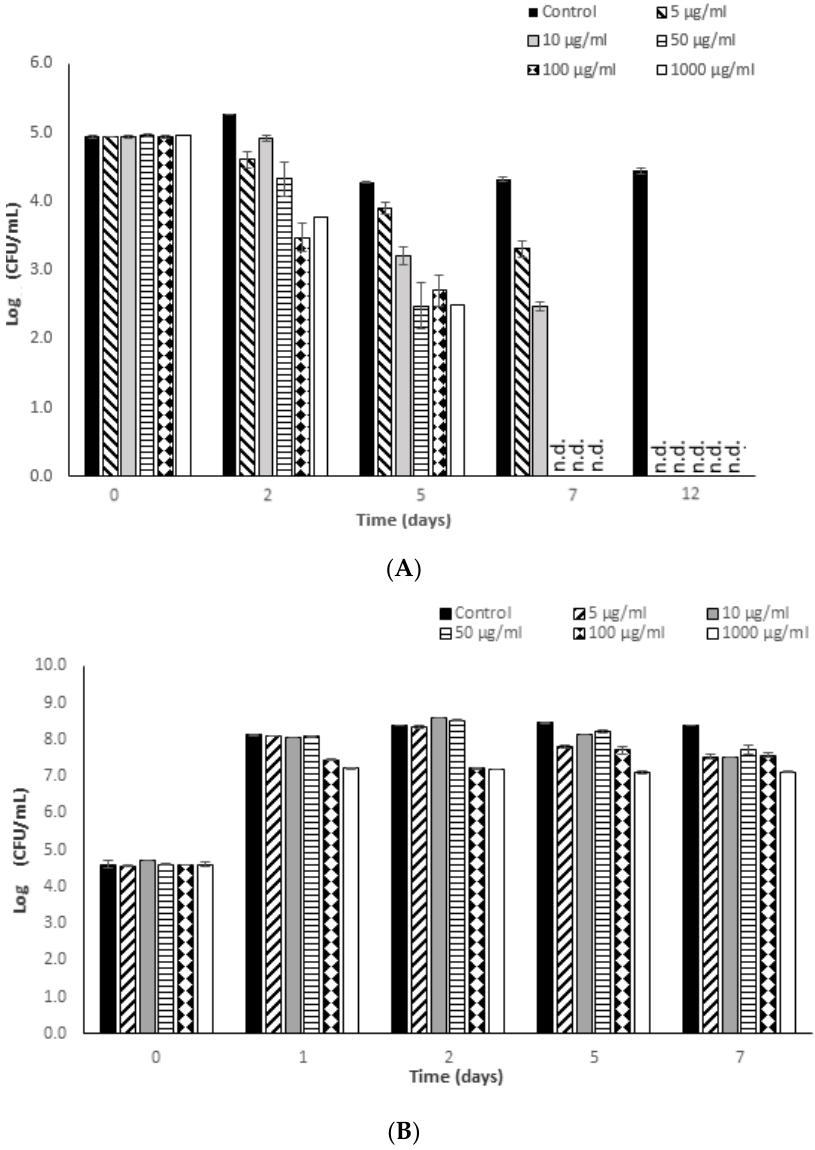
Figure 2. Kinetic results (log (CFU/mL) versus time (days)) obtained in the determination of the in vitro antimicrobial potential of fucoidan against Salmonella typhimurium in reference medium, Mueller Hinton Broth (MHB). ( A ) 8 °C (12 days); ( B ) 37 °C (7 days). Values below the detection limit are shown as not detected (n.d.).